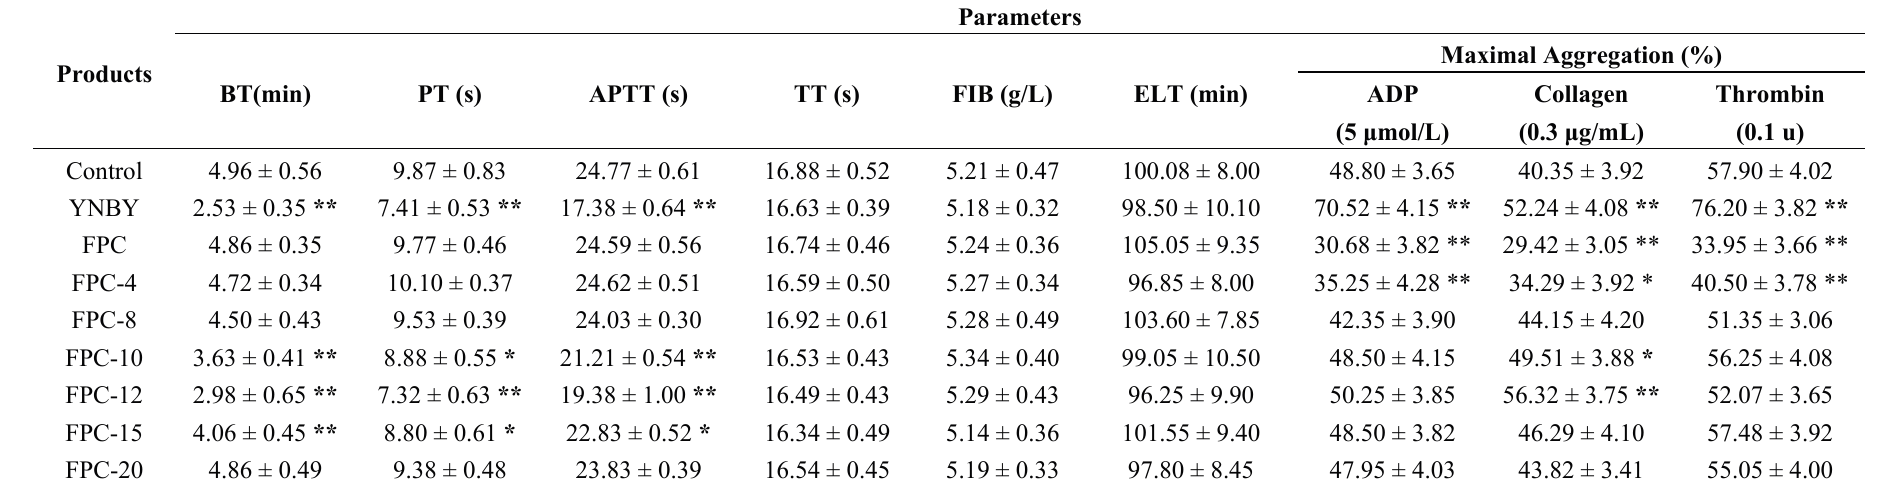
Table 3. Hemostatic parameters of rat plasma affected by